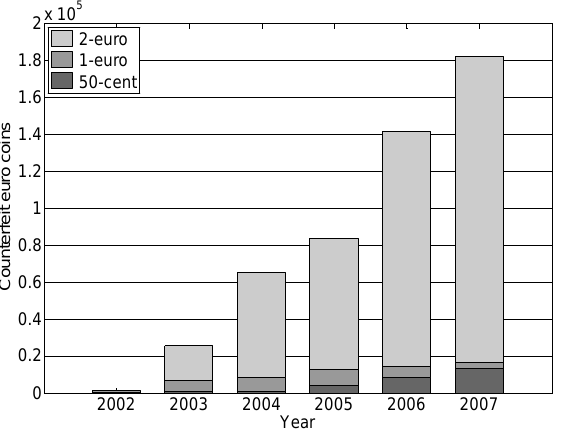
Figure 2. Counterfeit Euro coins detected in circulation up to